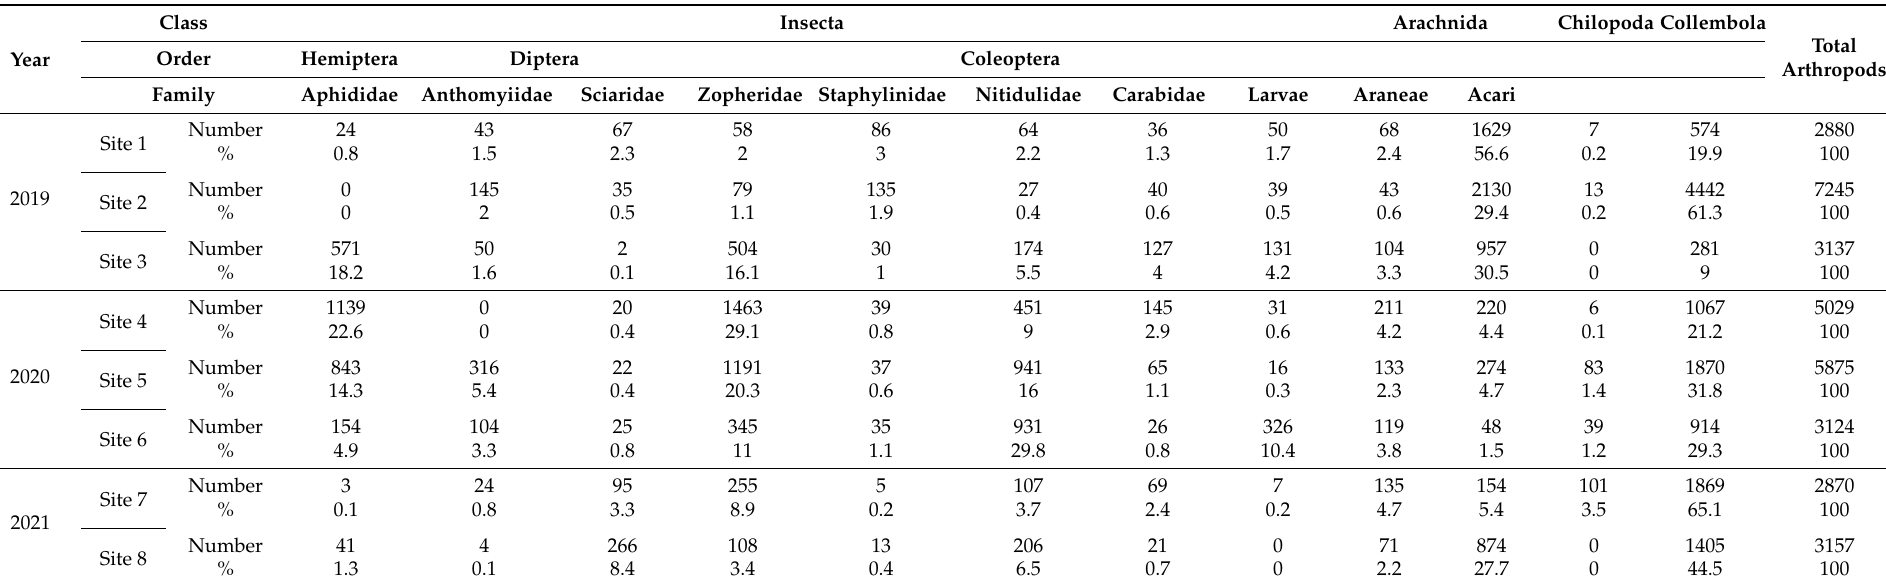
Table 3. Arthropod taxa activity, the percentage from total activity, and the classification of arthropod taxa that composes more than 1% of the total arthropod activity per site and